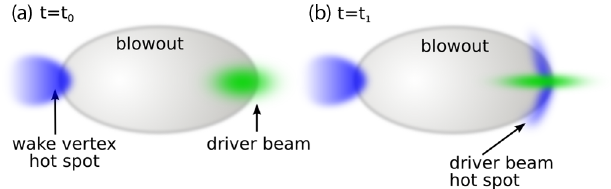
FIG. 1. Illustration of the plasma blowout time evolution ( t 0 < t 1 ), depicting sources of huge electric field spikes or hot spots (blue shade) in PWFA. (a) The blowout vertex, where recoalescing plasma electrons generate an electric field spike and (b) the one concurrent with the drive beam, which is subject to plasma lensing and betatron